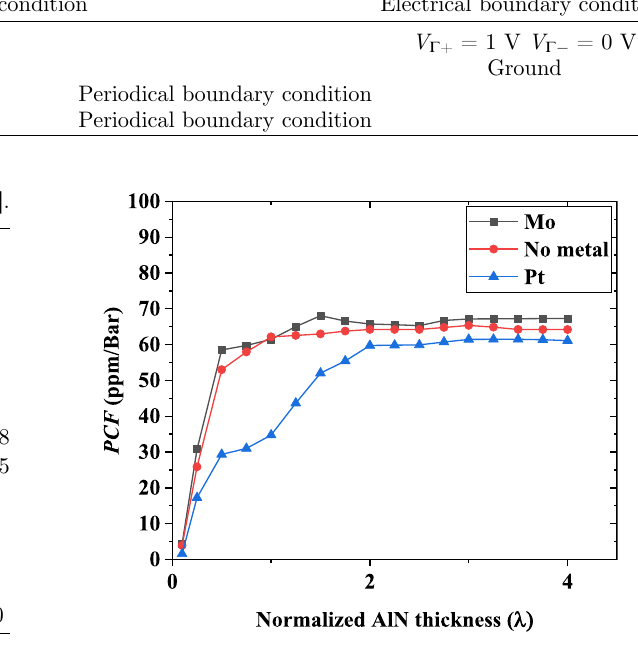
Figure 3. PCF for the different metal layer materials as a function of normalized AlN thickness.